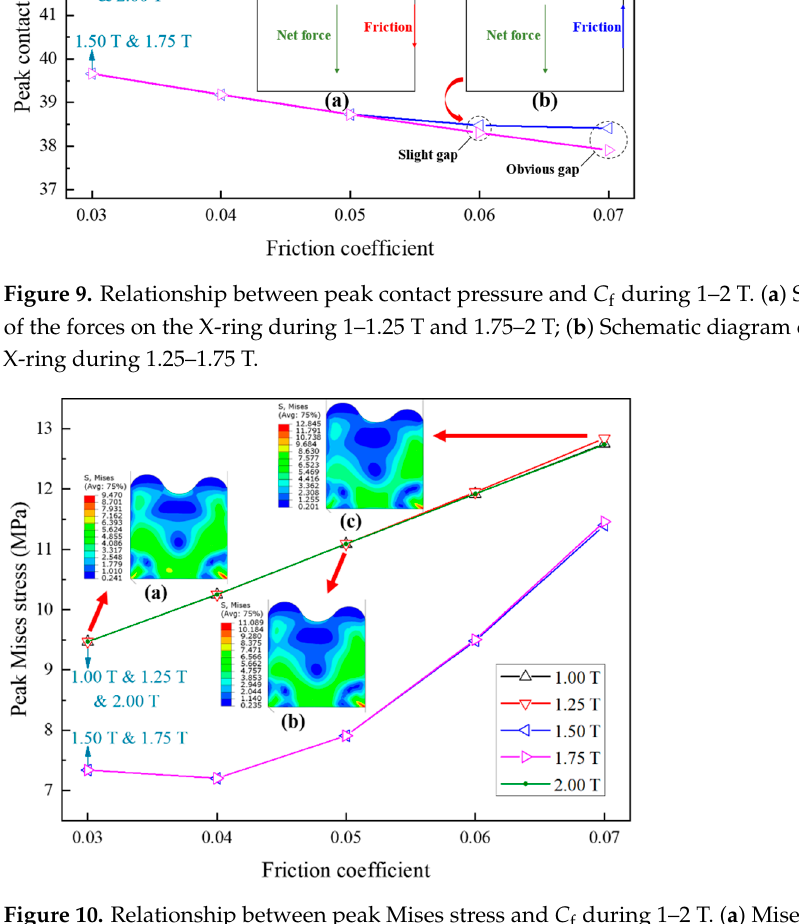
Figure 10. Relationship between peak Mises stress and C f during 1–2 T. ( a ) Mises stress diagram of X-ring at 1.25 T when C f is 0.03; ( b ) Mises stress diagram of X-ring at 1.25 T when C f is 0.05; ( c ) Mises stress diagram of X-ring at 1.25 T when C f is 0.07.